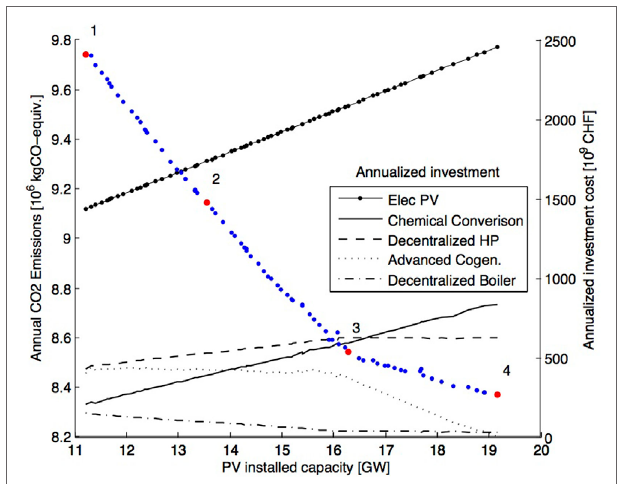
FigUre 10 | Annual CO 2 emissions and annualized investment cost VS installed capacity